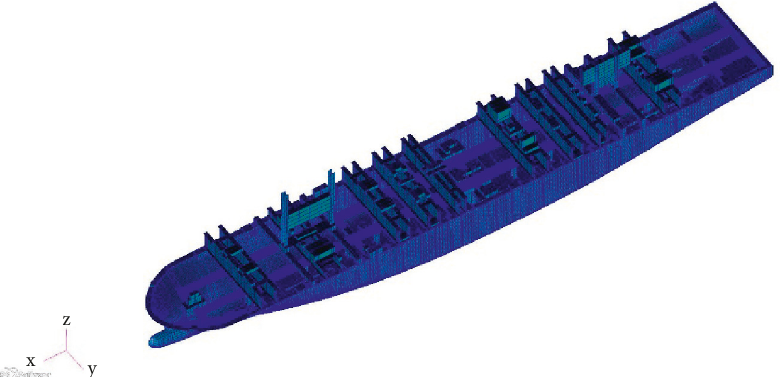
Figure 10: FEM of the containership of full load